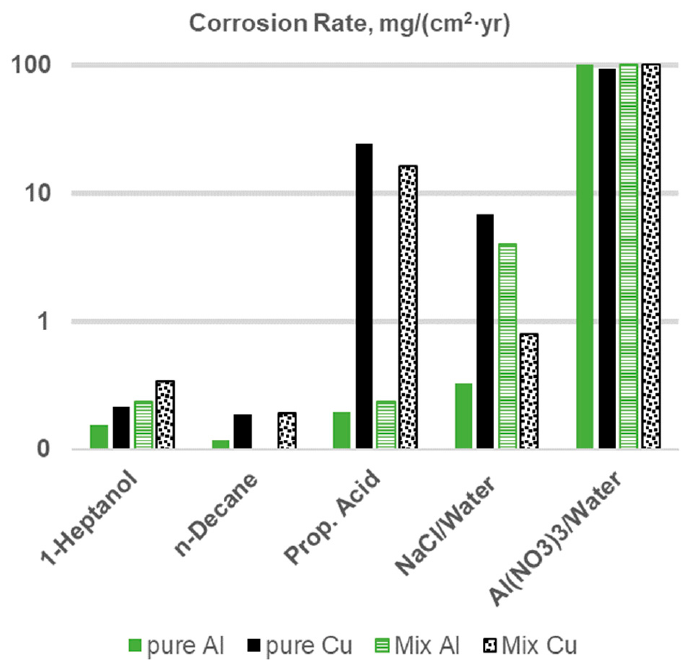
Figure 6. Summary of final corrosion rates calculated after 42 days of immersion tests, shown on a logarithmic scale.